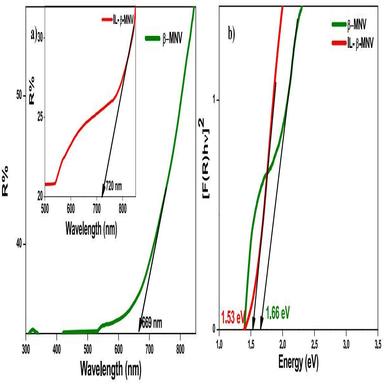
(a) UV-DRS spectra and (b) Tauc plots of β-MNV and IL-β-MNV.